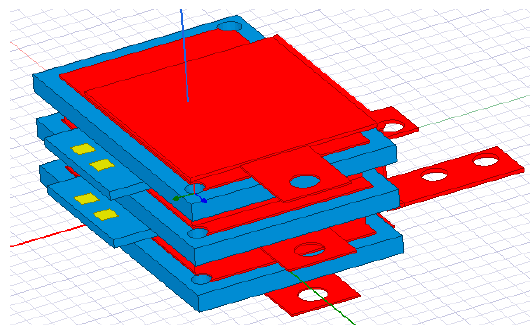
Figure 5. 3D Simulation model of MOSFET package module .